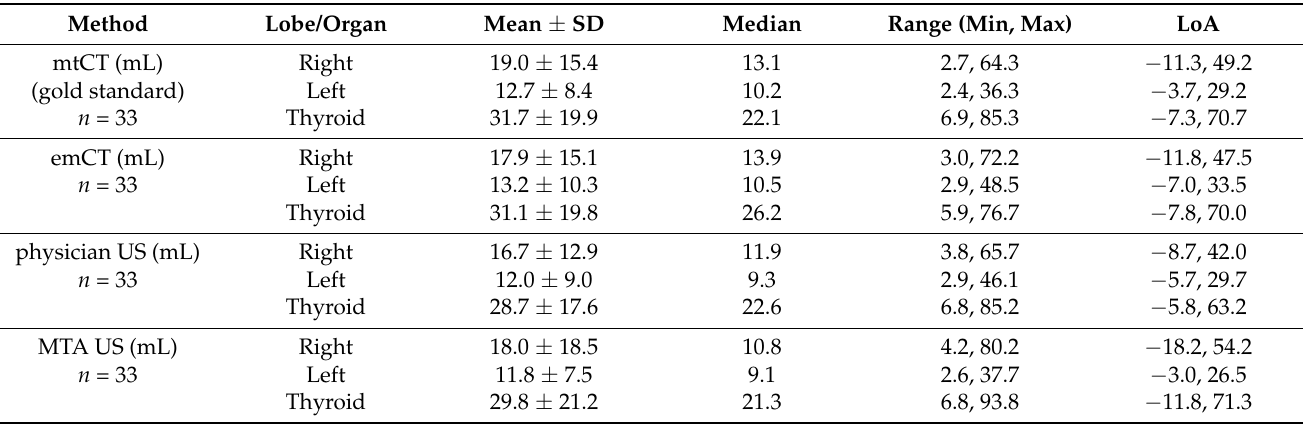
Table 1. Thyroid volume determinations on CT, conventional physician US, and MTA US cine loop review.